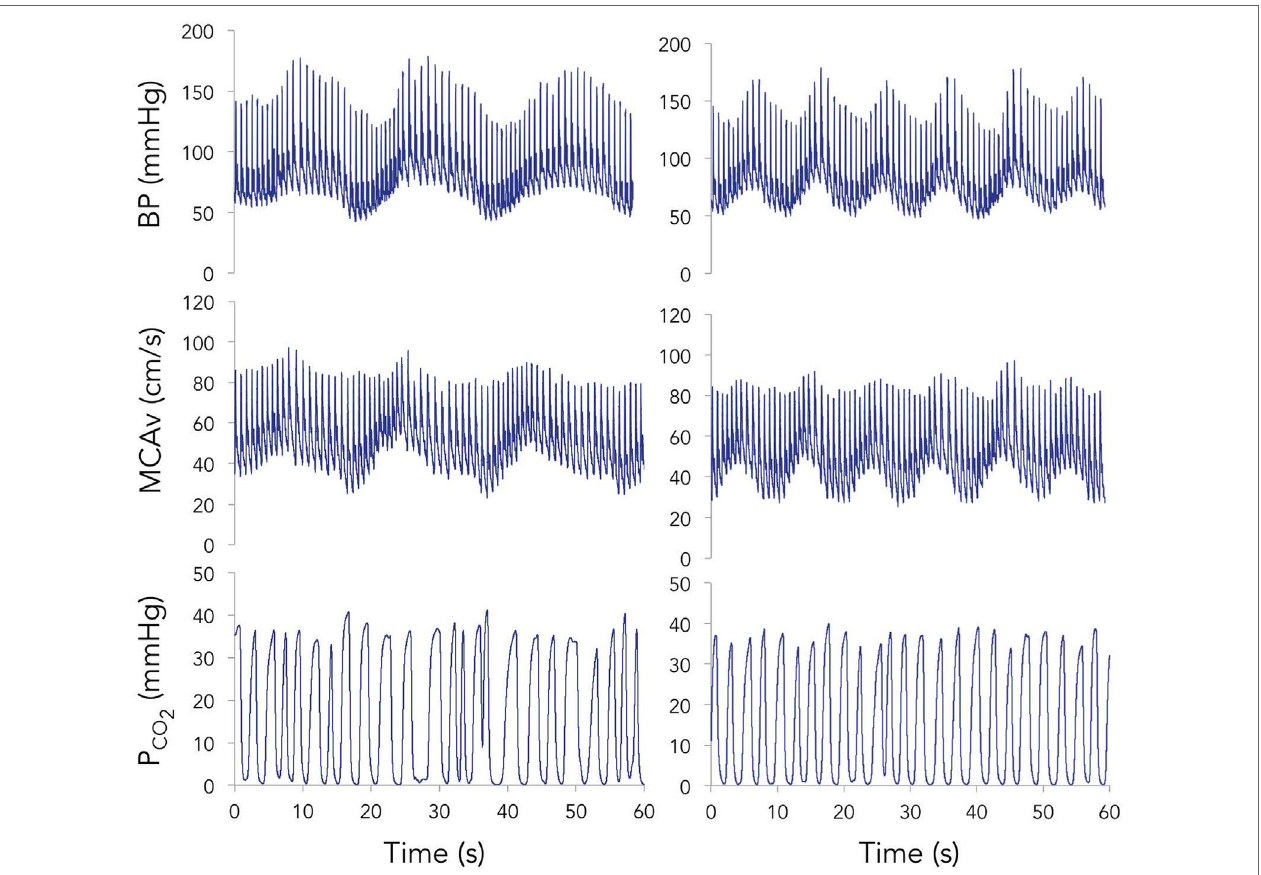
FigUre 1 | Representative time-series for blood pressure (BP) (top), middle cerebral artery blood velocity (MCAv) (middle), and expired carbon dioxide ( ) P (bottom) during 60 s of squat–stand maneuvers performed at 0.05 (left) and 0.10 Hz